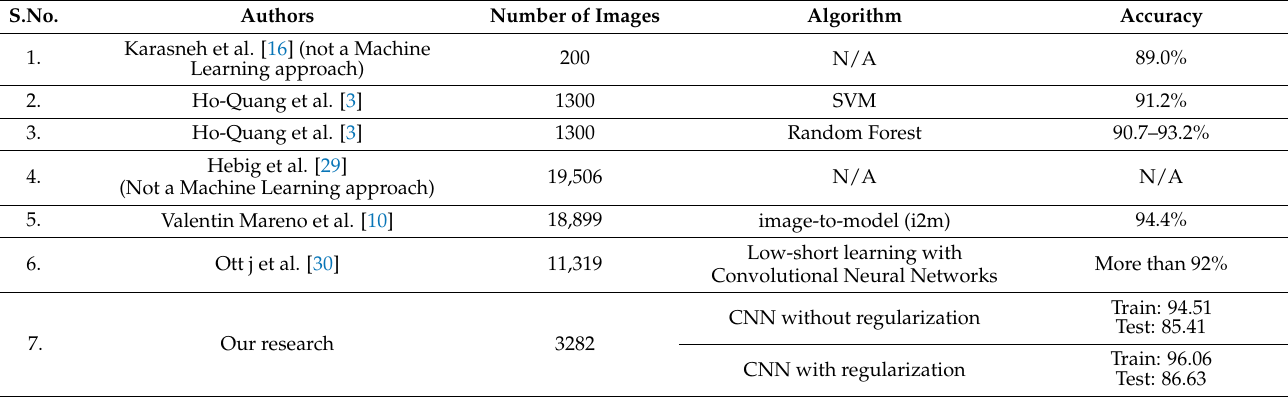
Table 3. Accuracy comparison with our